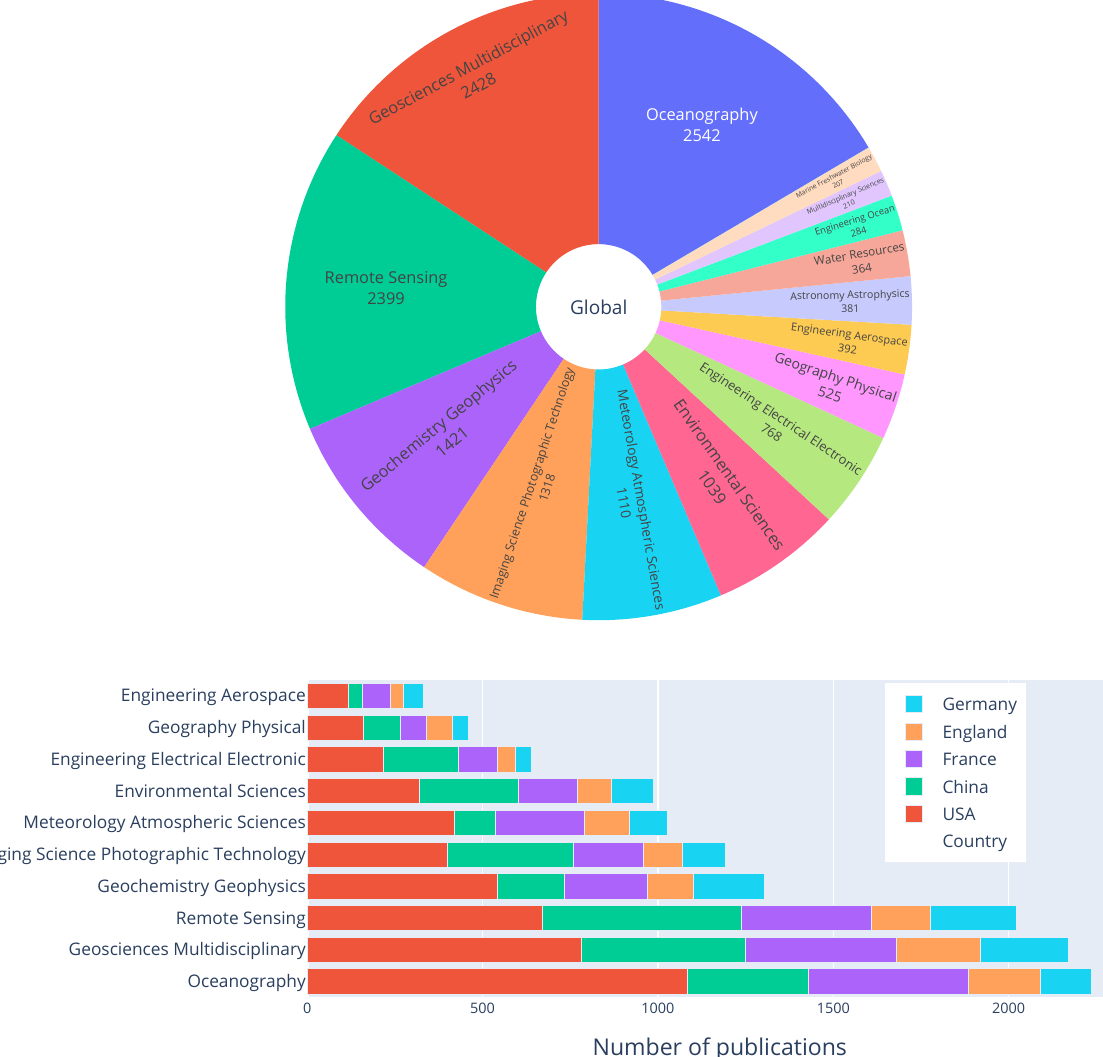
Figure 3. The categories of publications of satellite altimetry. The pie chart displays the distribution of categories with more than 200 publications on a global scale. The distribution of categories among the top five nations is displayed in the bar graph below. Be aware that one publication may belong to several relevant